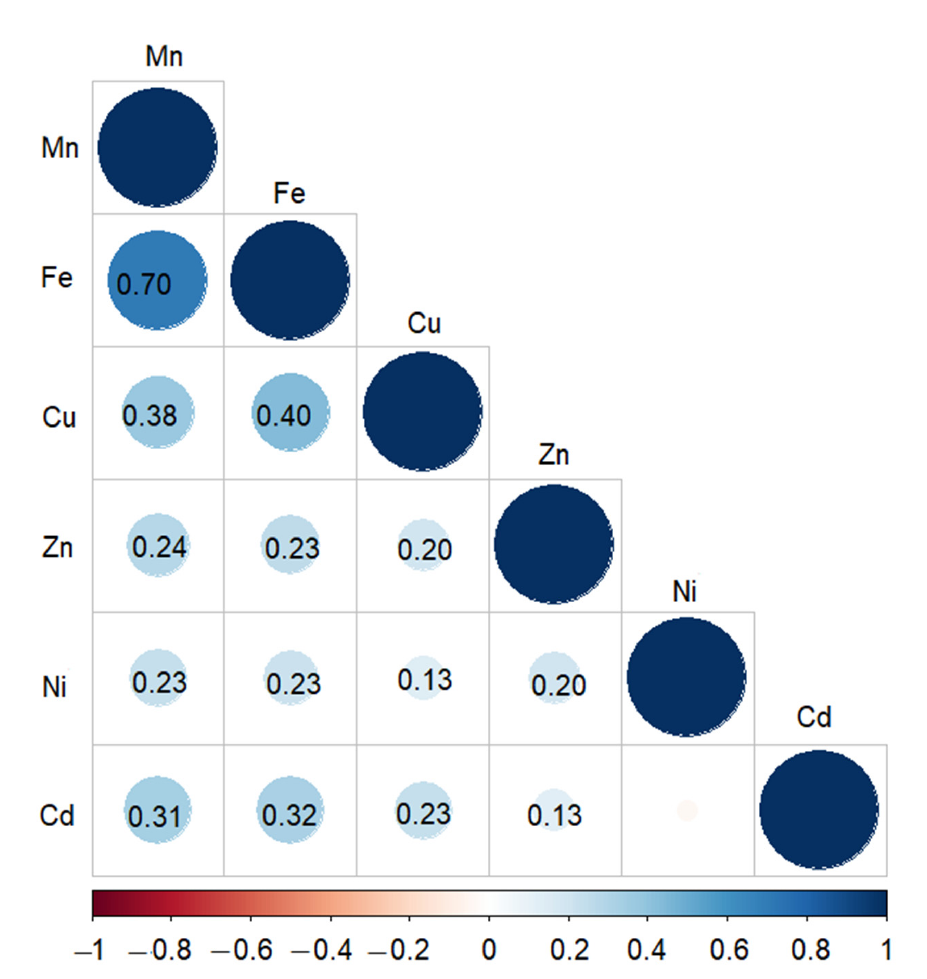
Figure 2. Correlation plot for the measured metals. The size and the colour of the circles indicate the significance level. The blue colour indicates a positive correlation between the measured metals.